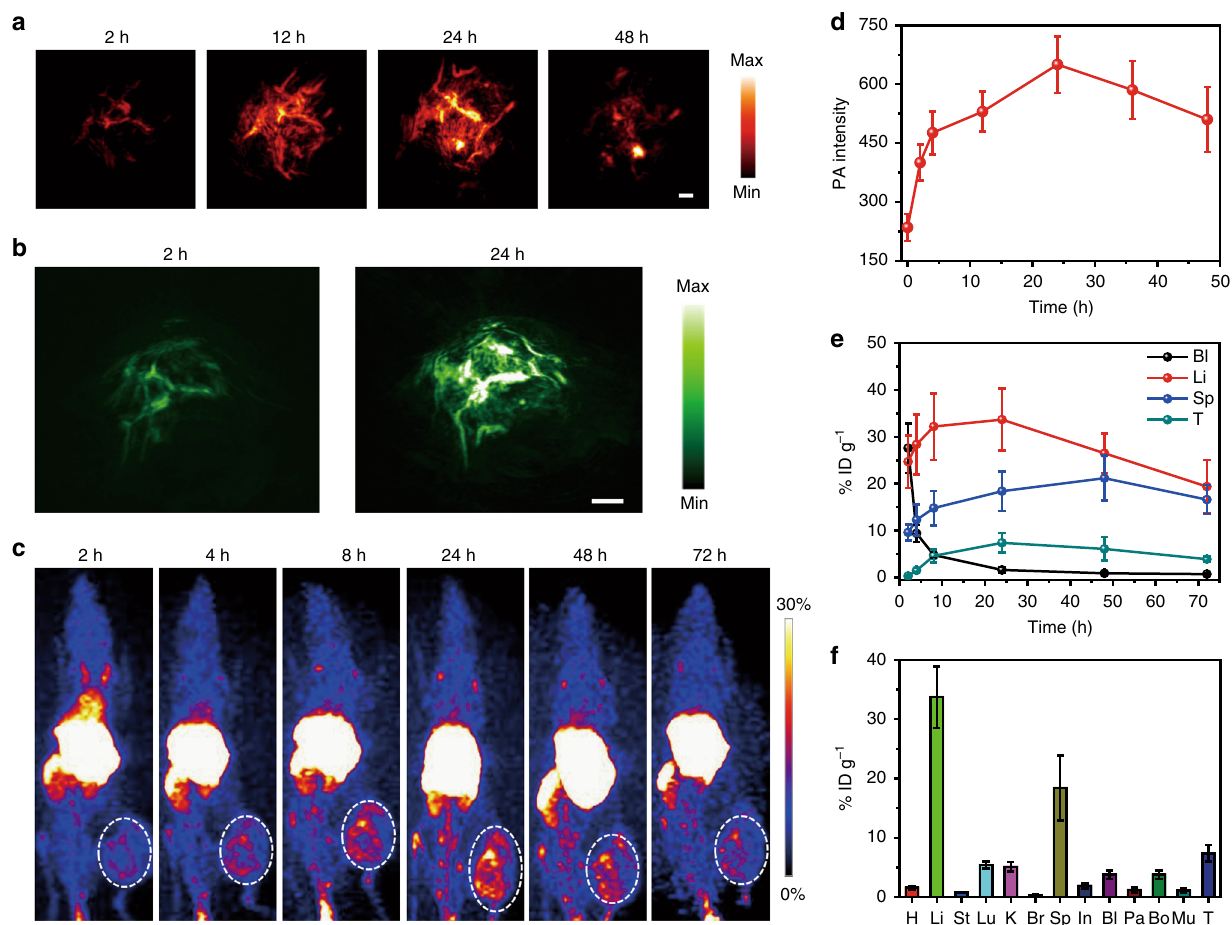
Fig. 6 In vivo PA and PET imaging. a Representative PA maximum imaging projection (MIP) and b 3D images of tumour in a living mouse after systemic administration of SCNPs through i.v. injection. Scale bar is 2 mm. c Decay-corrected whole-body coronal PET images of HeLa tumour-bearing mice at 2, 4, 8, 24, 48, and 72 h after i.v. injection of 150 μ Ci of 64 Cu SCNPs. d Quanti fi cation of PA intensities at 671 nm as a function of post-injection time of SCNPs ( n = 3). e Time-activity curves quanti fi ed based on PET images ( n = 3). f Biodistribution of the 64 Cu SCNPs in mice bearing HeLa tumours at 24 h post- injection ( n = 3). Data are expressed as means ±